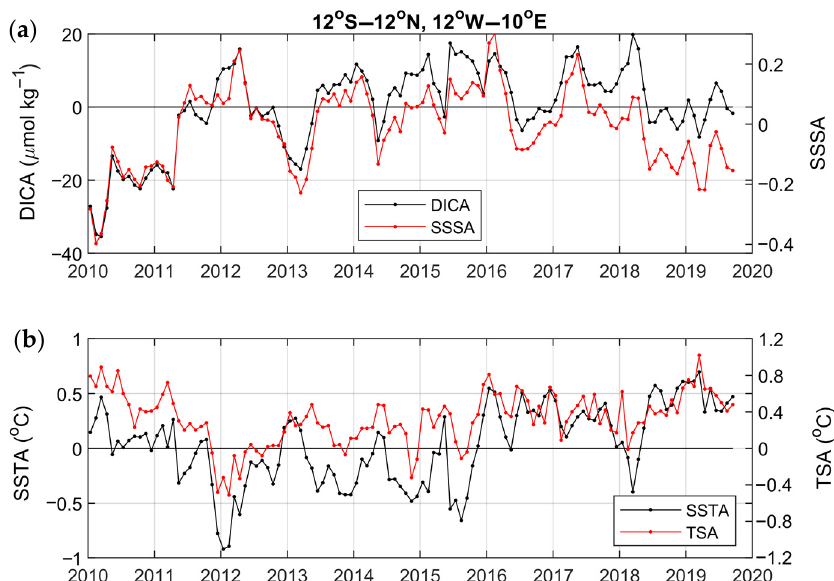
Figure 12. ( a ) Monthly DIC and SSS anomalies (DICA and SSSA), ( b ) SST anomalies (SSTA) and Tropical Southern Atlantic (TSA) index from January 2010 to September 2019.